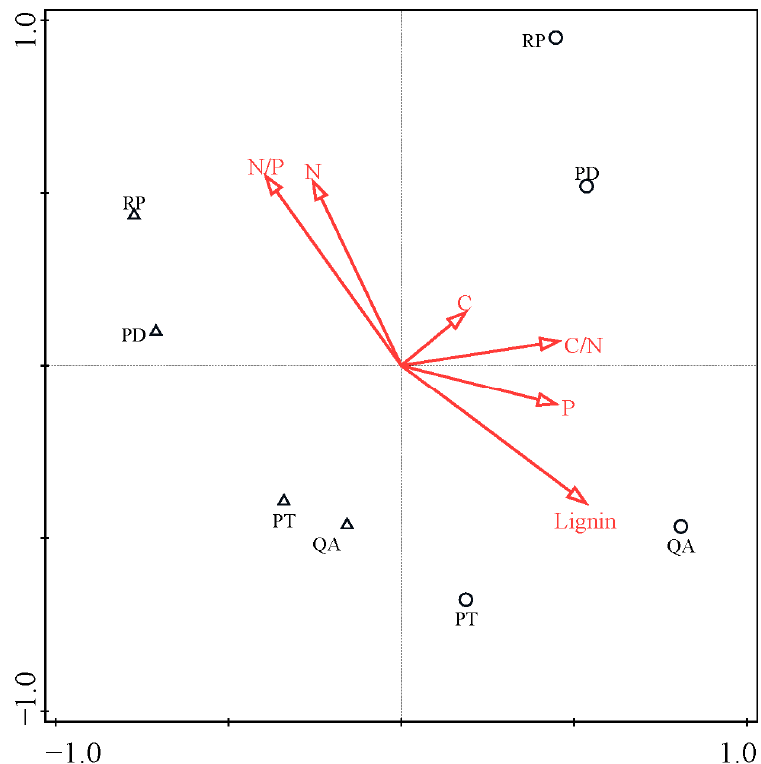
Figure 6. Redundancy analysis (RDA) based on the bacterial community structure and initial litter chemistry. RP: R . pseudoacacia , QA: Q . acutissima , PD: P. densiflora and PT: P . tabulaeformis . The triangles represent the leaf litter, and the circles represent the fine